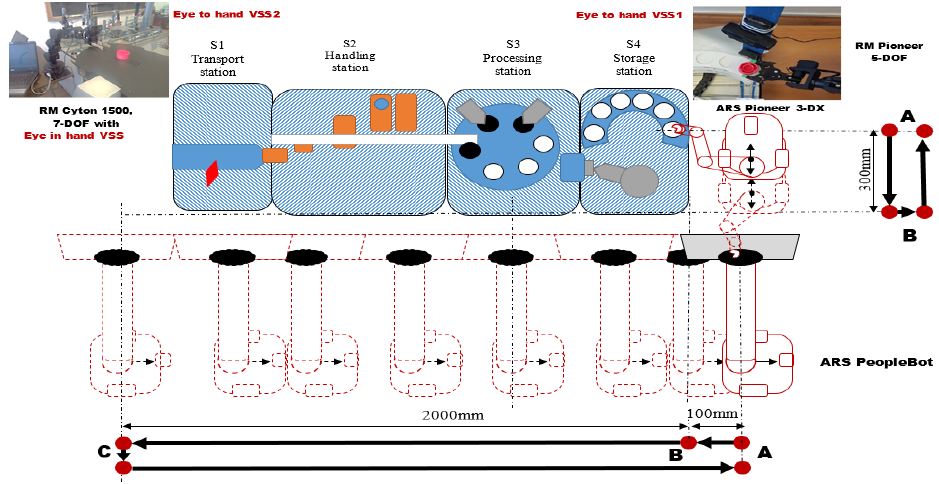
Figure 3. P/RML assisted by two ARSs, two RMs, two eye to hand VSSs and one eye in hand .